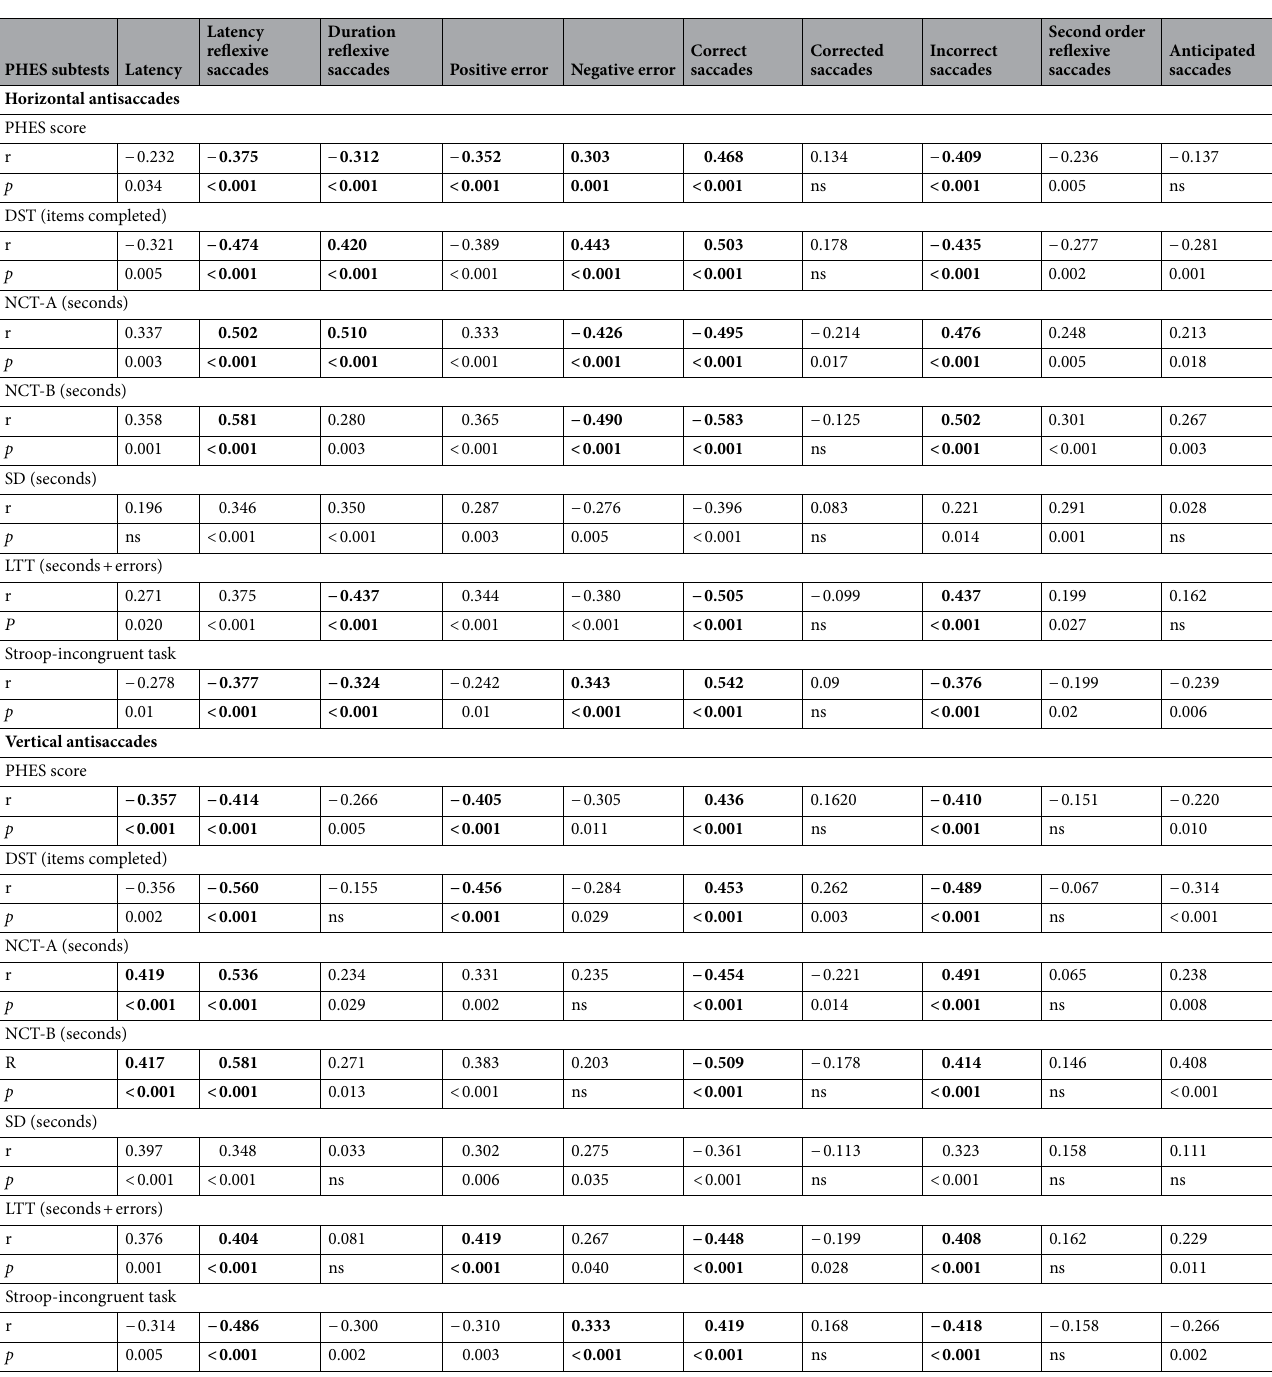
Table 5. Correlations between neuropsychological tests and antisaccades test parameters. Spearman correlation parameters are shown. PHES, Psychometric Hepatic Encephalopathy Score; DST, Digit